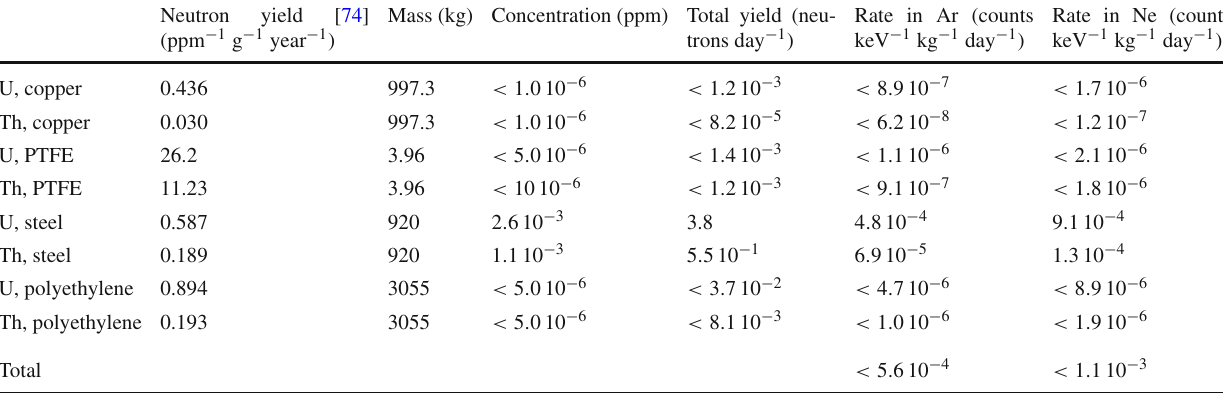
Table 5 Estimates of the expected counting rate in TREX-DM using Ar or Ne from radiogenic neutrons produced by uranium and thorium presence in the main materials of the set-up Neutron